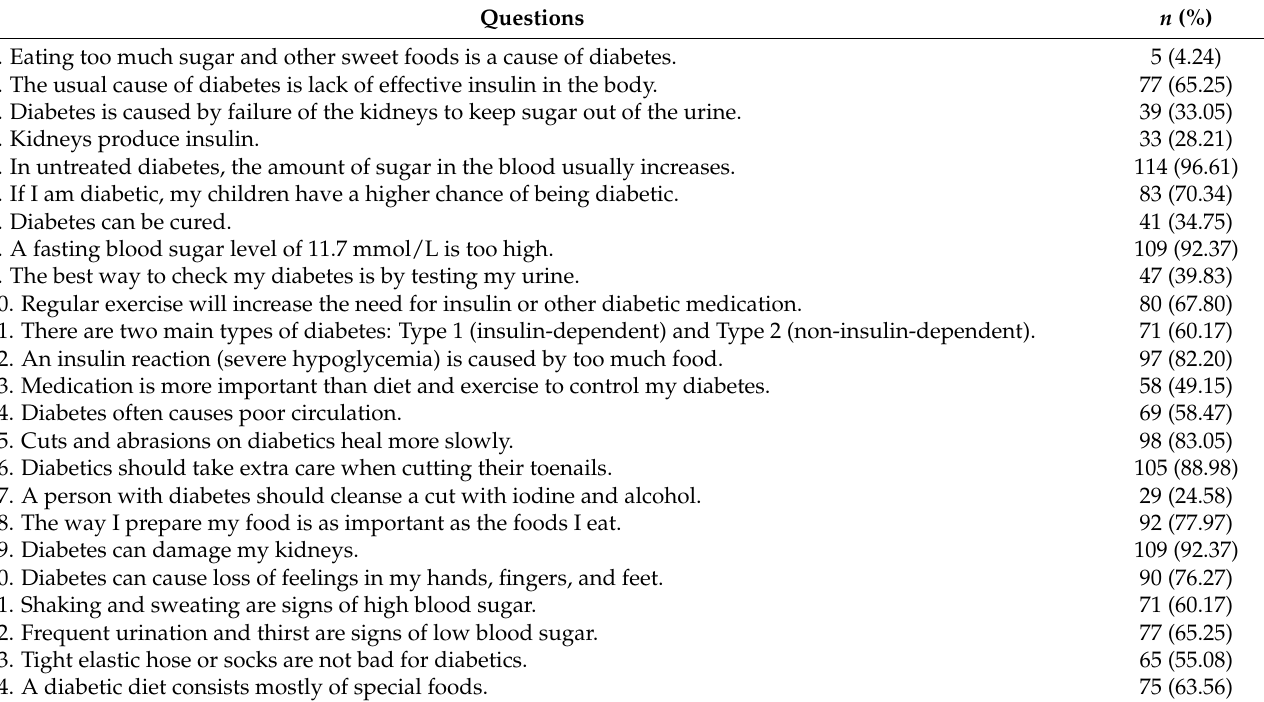
Table 2. Number of participants with correct answers to the questions in diabetes knowledge